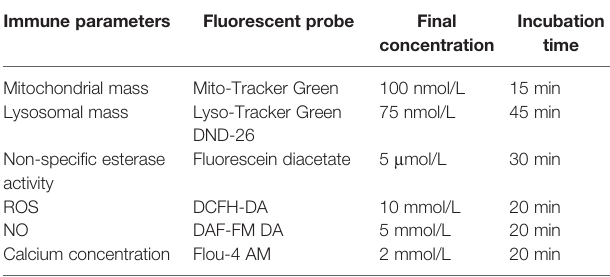
TABLE 1 | Final concentration and incubation time of probes used in this